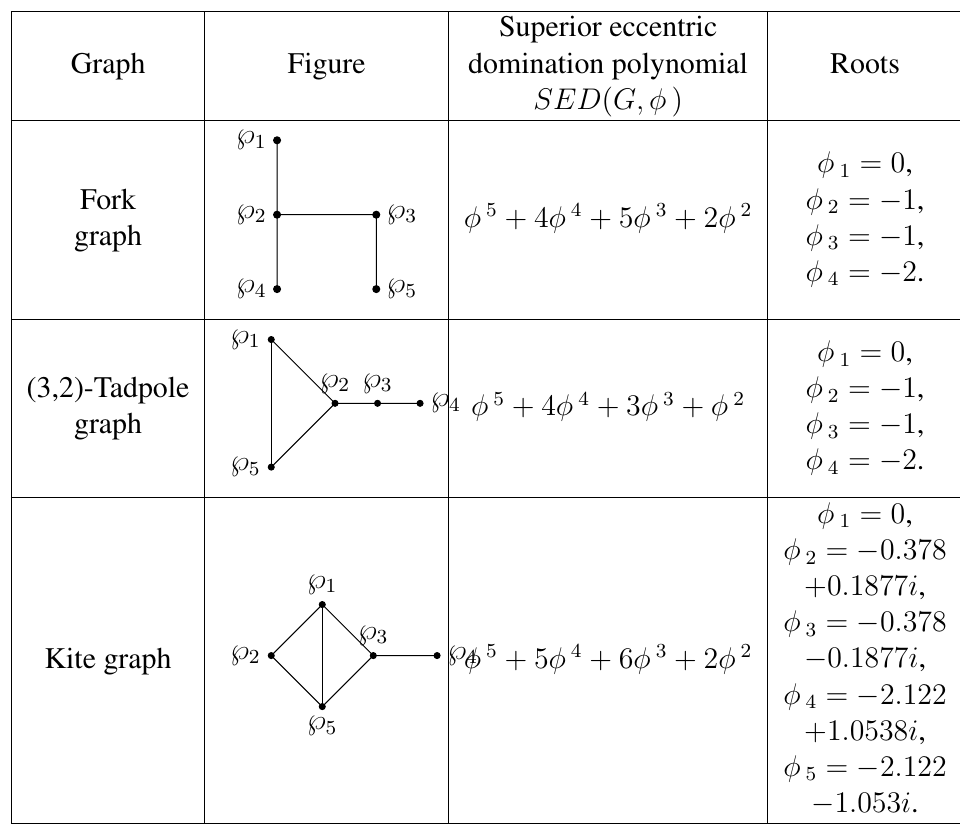
Superior eccentric domination